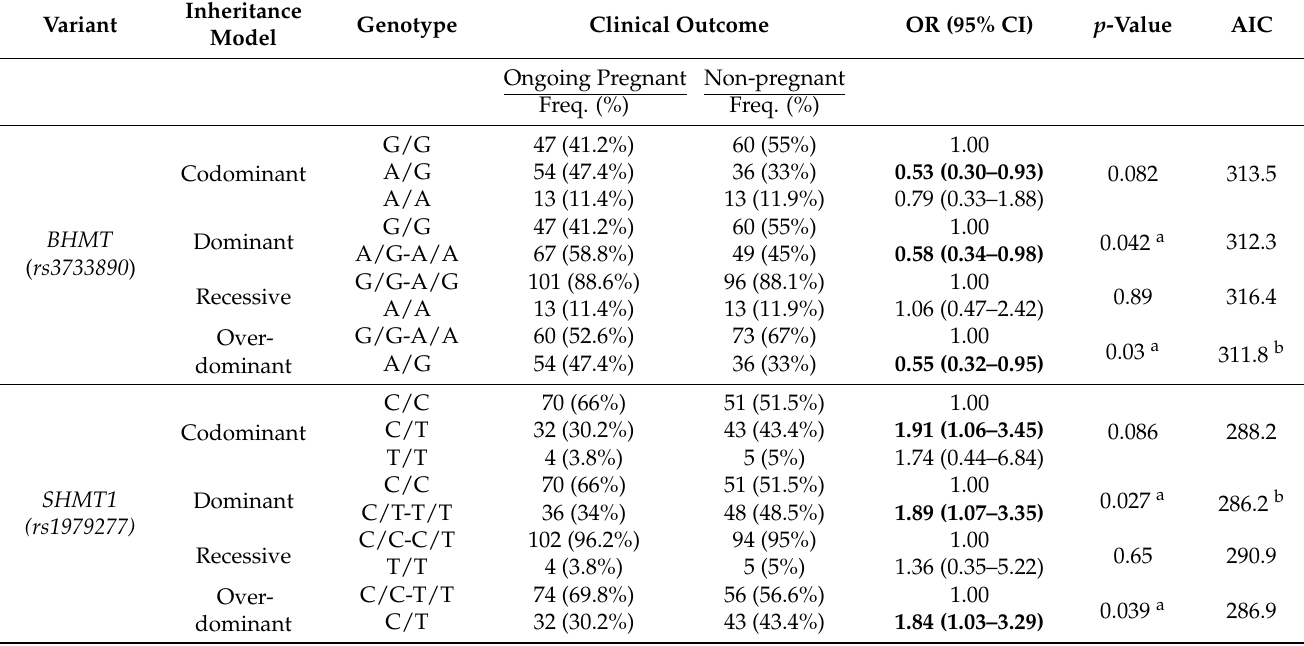
Table 3. Logistic regression analysis of gene variants and the probability of achieving a defined clinical